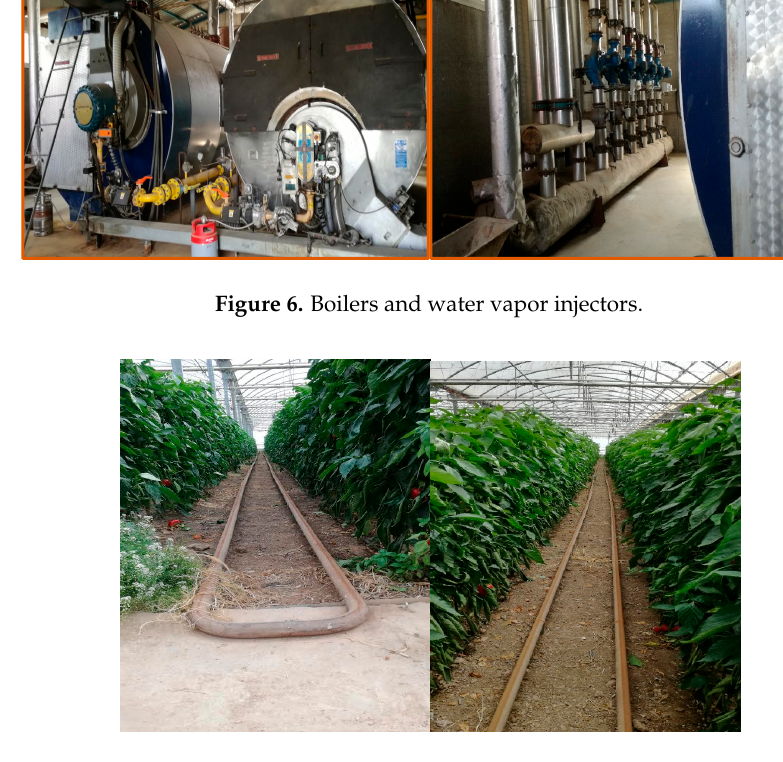
Figure 8. Greenhouse costs. Source: fieldwork. Table 4. Average operational costs in greenhouses 2002–2015. Source: fieldwork.